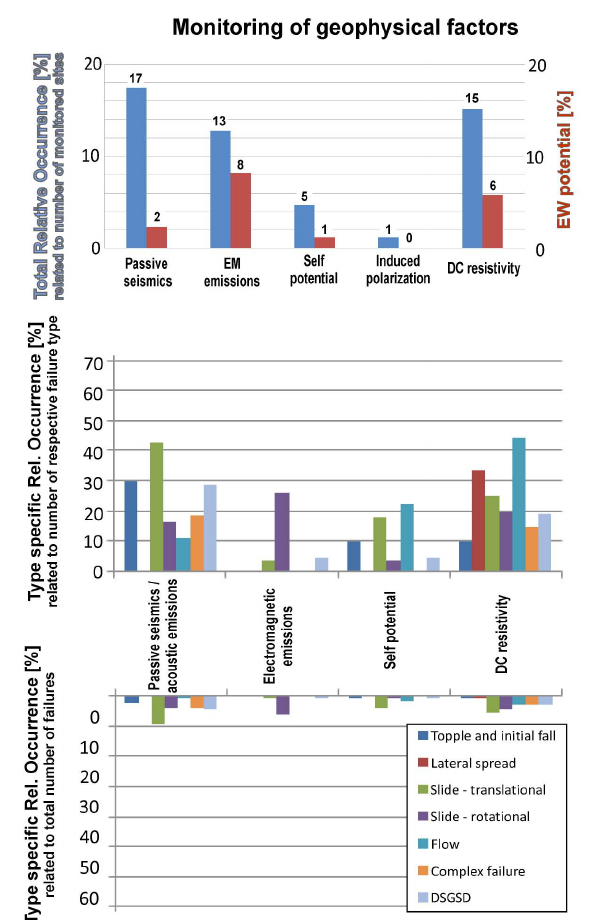
Fig. 11. Review of total relative occurrence, EW potential and type- specific relative occurrence of of geophysical monitoring parame- ters from the 86 monitored landslide